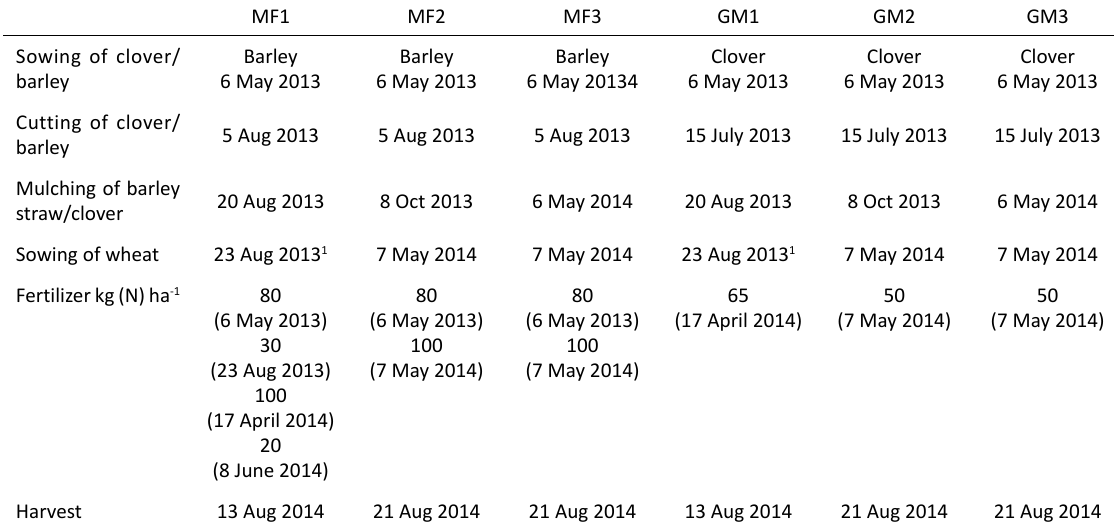
Table 1. Management of the